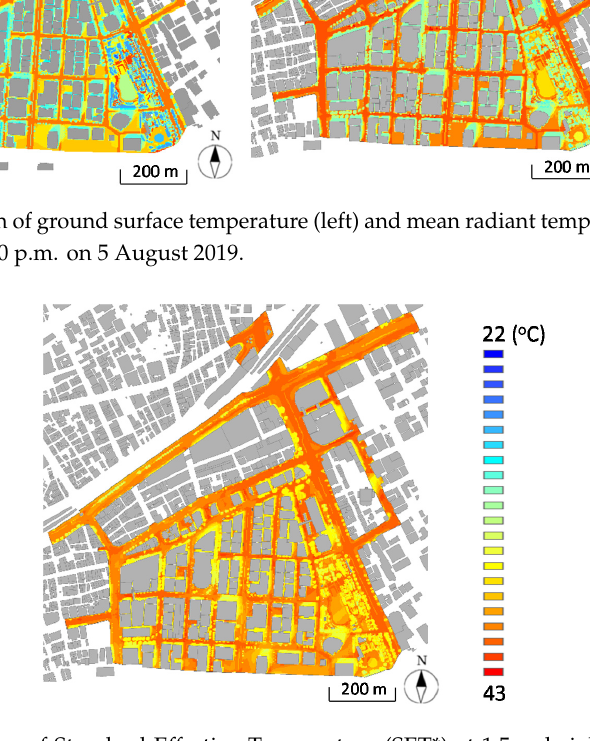
Figure 9. Distribution of Standard Effective Temperature (SET*) at 1.5 m height at 1:00 p.m. on 5 August 2019. August